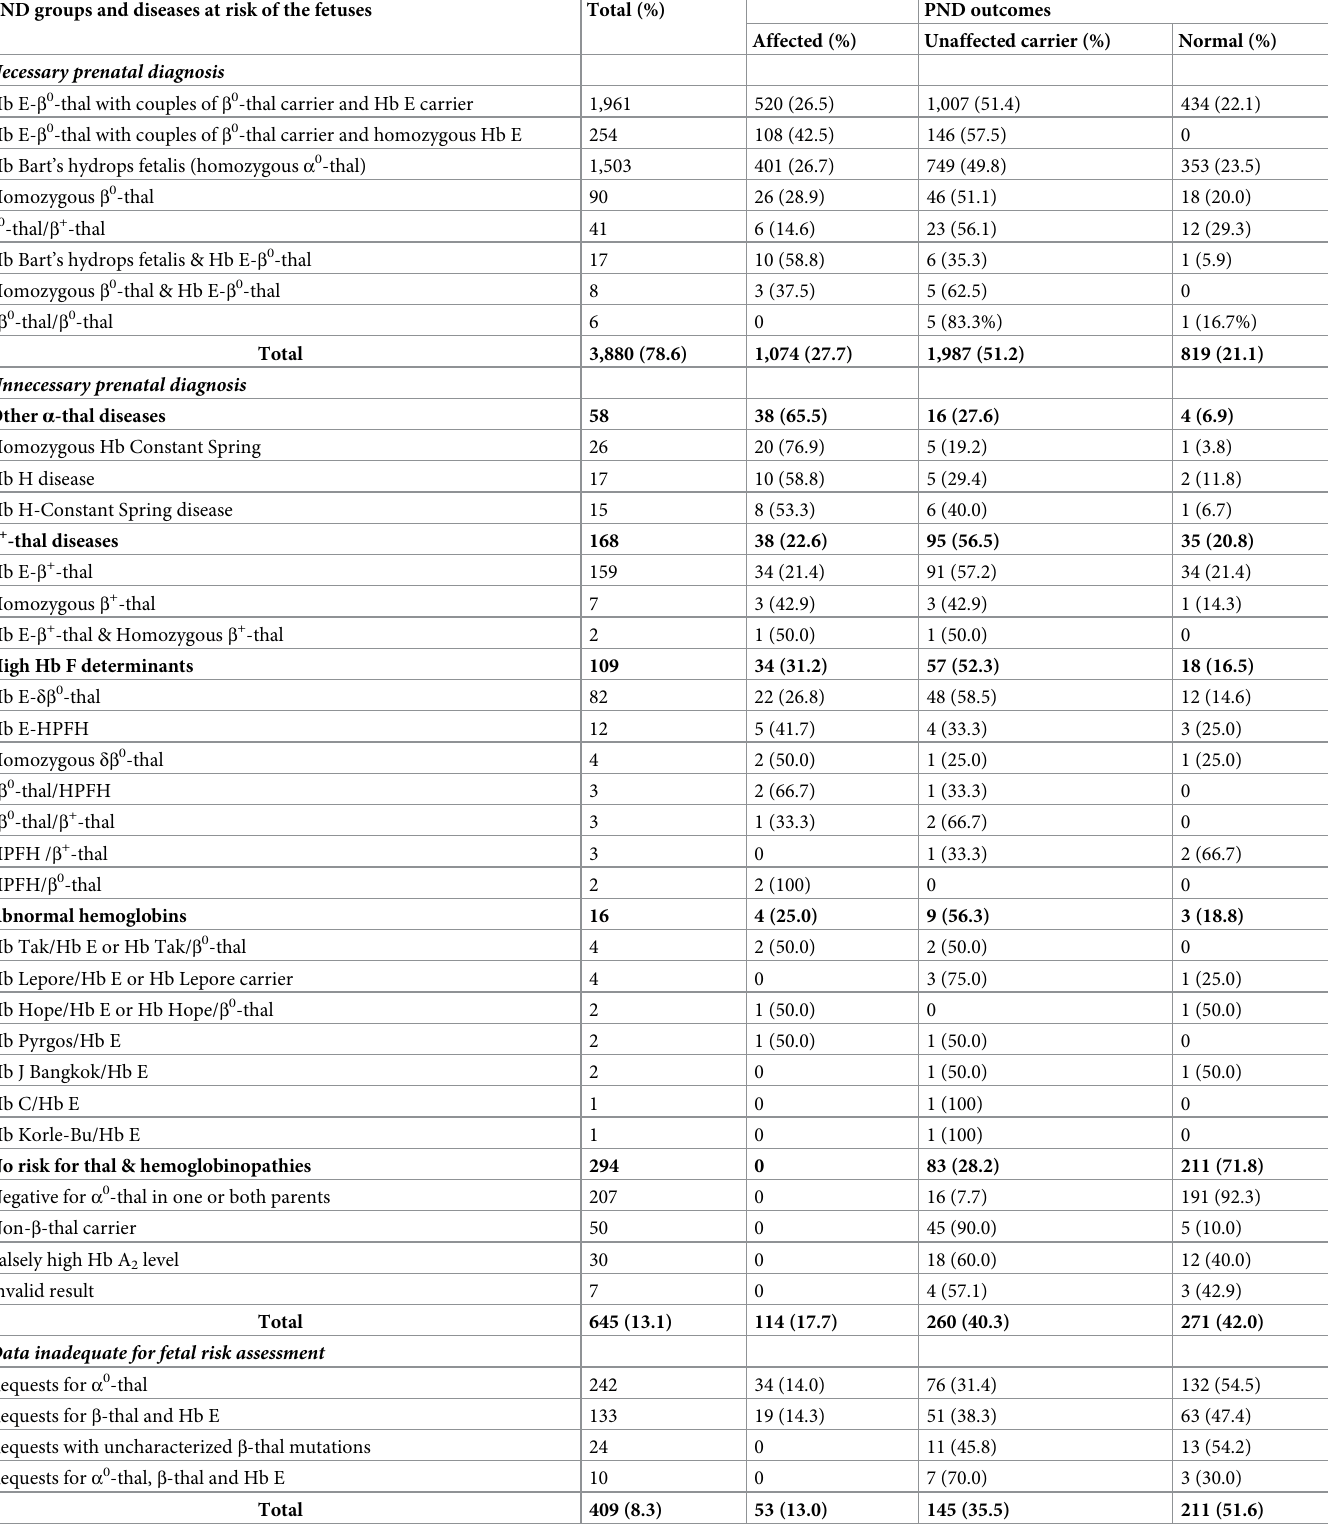
Table 3. Proportions of the 4,934 fetuses and at-risk diseases in each PND group and the PND outcomes. CS = Hemoglobin Constant Spring, thal = thalassemia. PND groups and diseases at risk of the